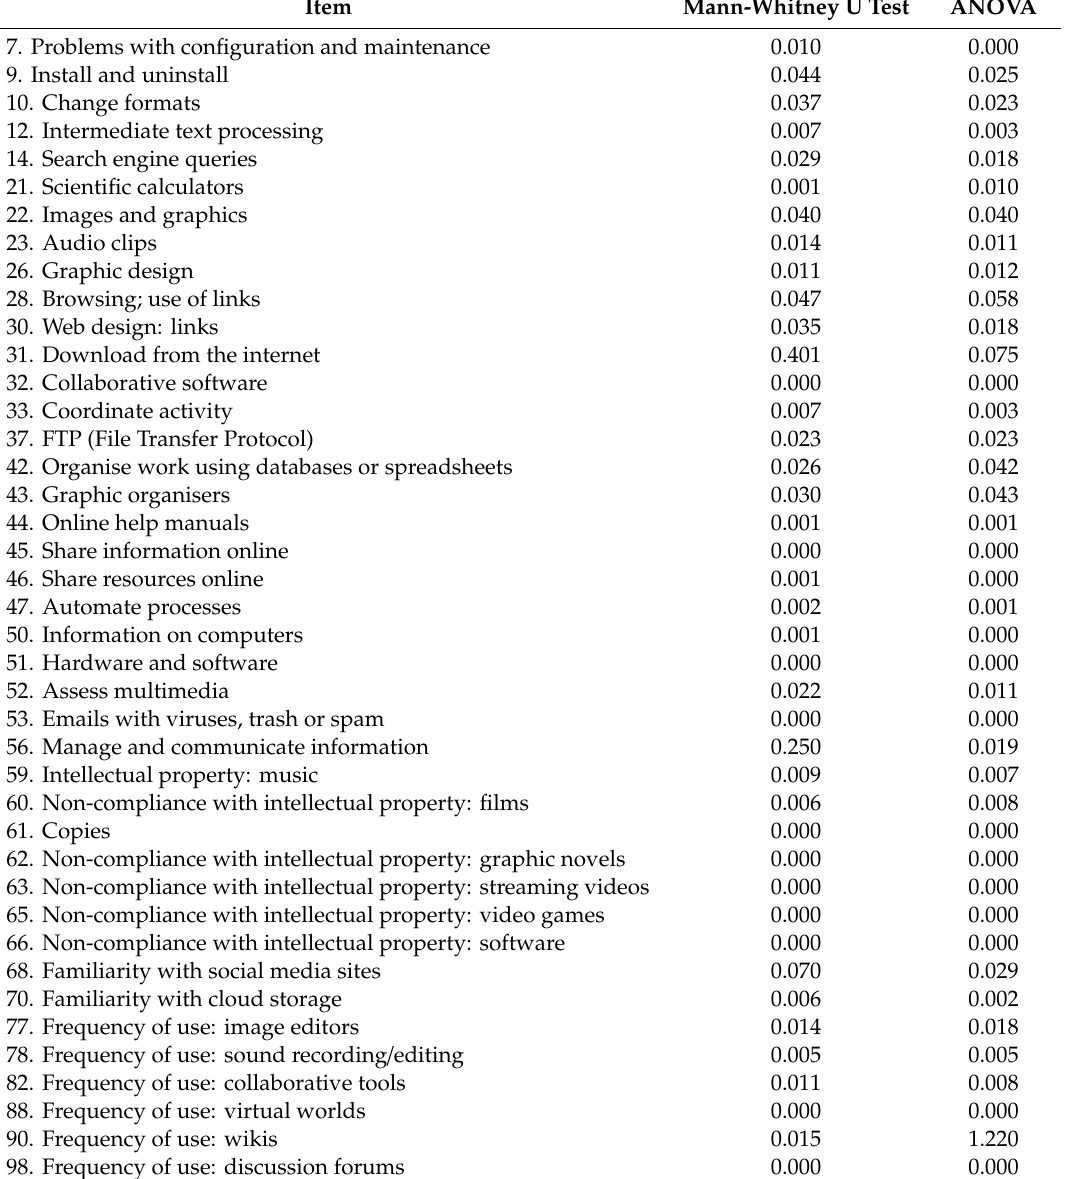
Table 3. Items related to the variable of